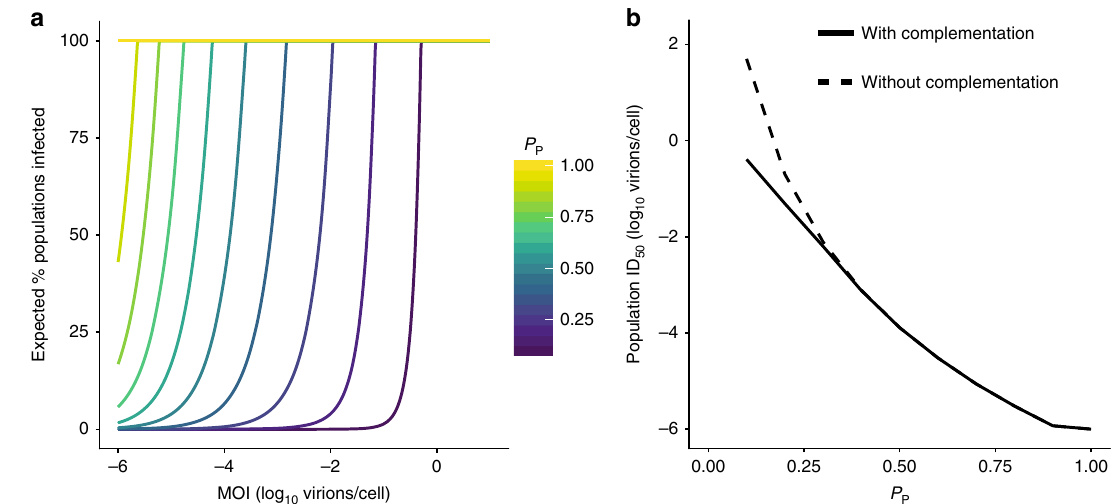
Fig. 3 Requirement for coinfection poses a barrier to establishing an infection in a population of cells. To de fi ne the impact of IVGs on the ability of a virus to establish infection in a population of cells, the probability that a population of 10 6 cells became infected by a given number of virions was calculated. a The percentage chance of at least one cell containing eight genome segments following delivery of virions was calculated for each P P and across a range of MOIs. b The MOI that led to 50% of cell populations becoming infected (ID 50 ) was plotted as a function of P P , where complementation was possible (solid line), and where only complete viral genomes could initiate infection (dashed line). IVGs = incomplete viral genomes. Source data are provided as a Source Data fi